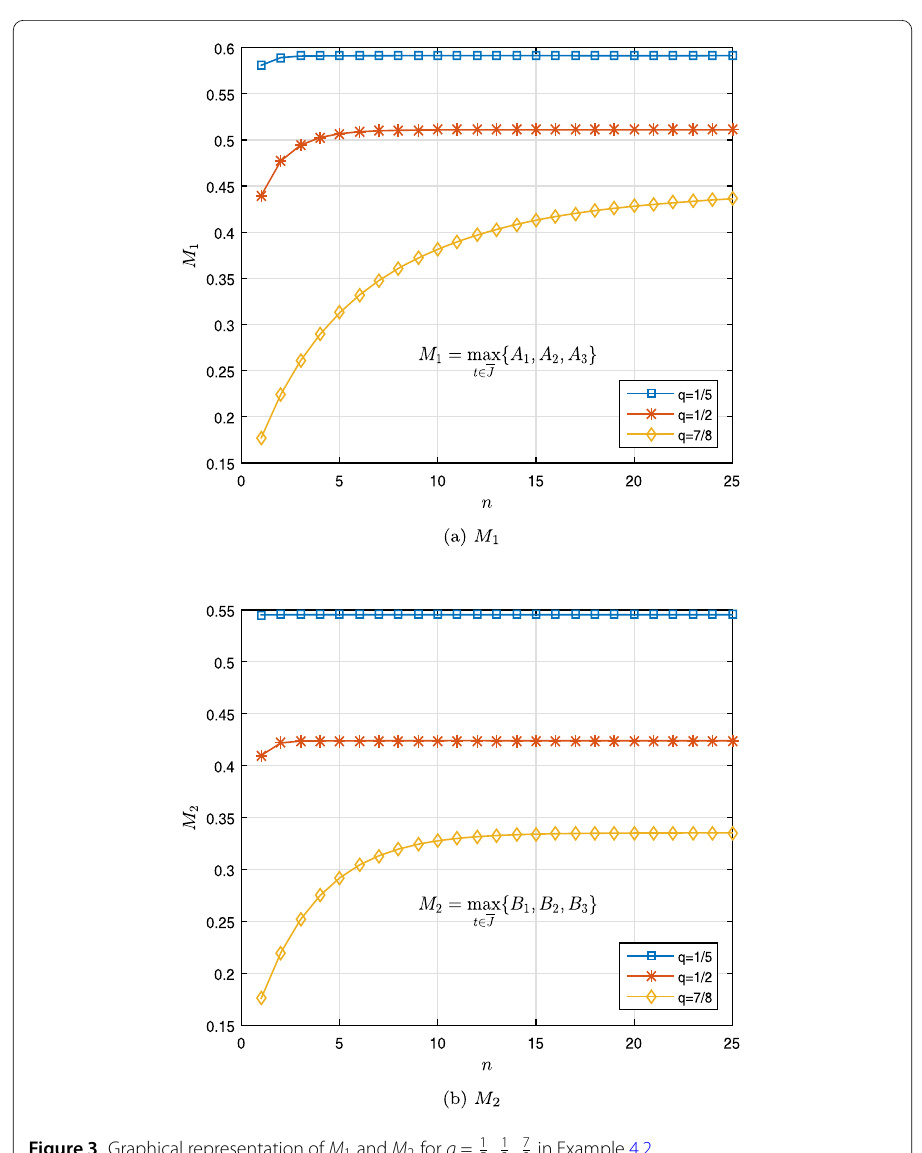
Figure 3 Graphical representation of M 1 and M 2 for q = 1